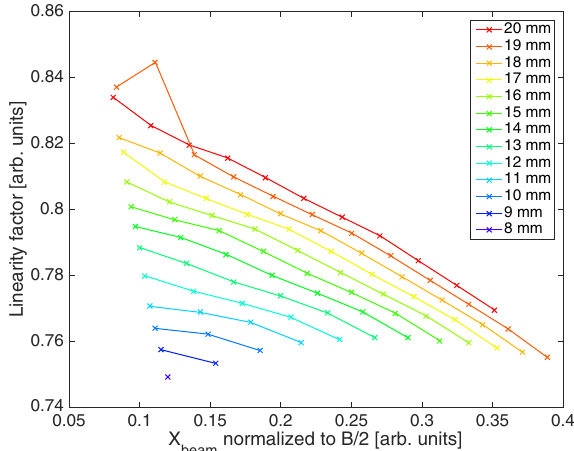
FIG. 11. Linearity factor as a function of the beam offset normalized to the BPM aperture for the TCTPV.4R2.B2 for different jaw gaps (see